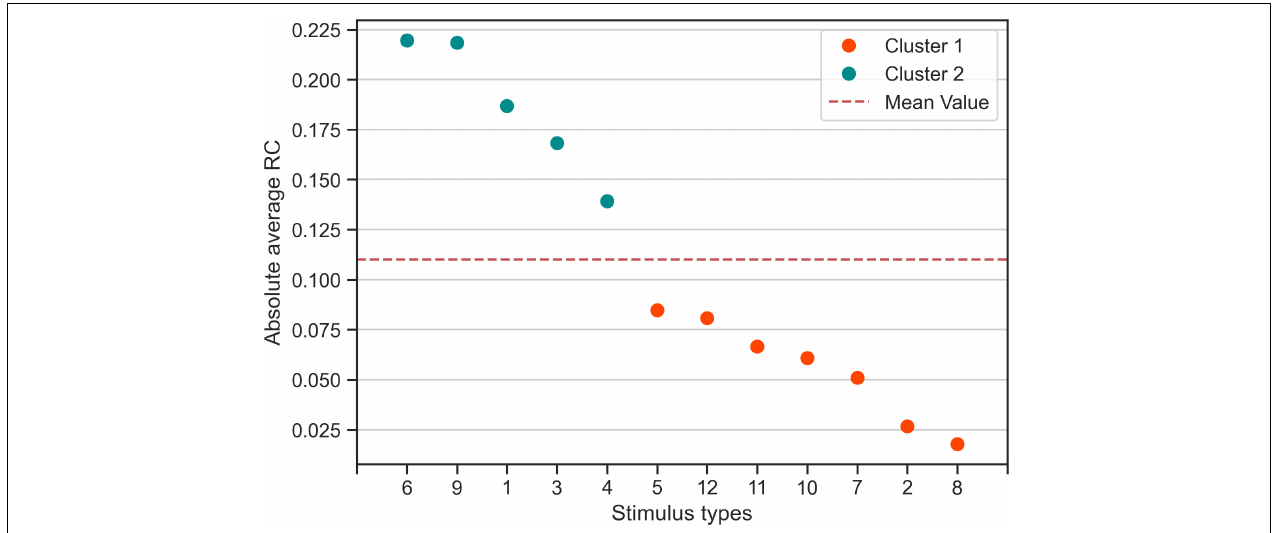
FIGURE 3 | Categorization of stimulus types based on absolute average response consistency (RC) values. Using the absolute of the RCs averaged across participants, we used K-means clustering to categorize the twelve 0% coherence stimulus types according to consistency averaged over participants. Cluster 1 (Orange) contains seven stimulus types for which participants made responses that are less consistent than the average (red dashed line). Cluster 2 contains the five stimulus types to which participants responded more consistently than on average.